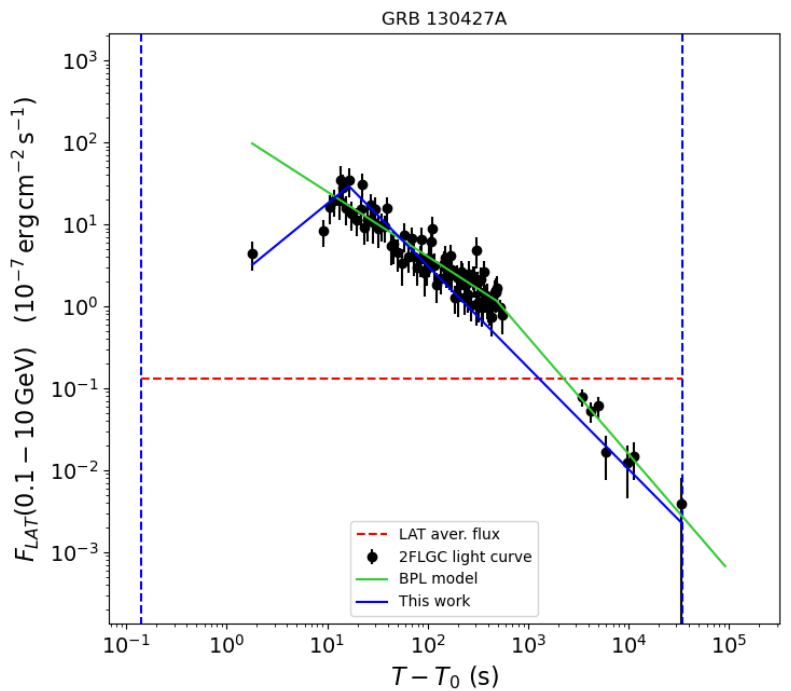
Figure 2. Comparison between the Fermi -LAT light curve of GRB 130427A and the model based on Equations (4) and (5). The vertical blue dashed lines mark the temporal window of the LAT signal, the red horizontal line is the average energy flux collected during the emission, the green continuous line is the 2FLGC broken power-law fit to the data, while the blue continuous line is a model using the light curve of Equation